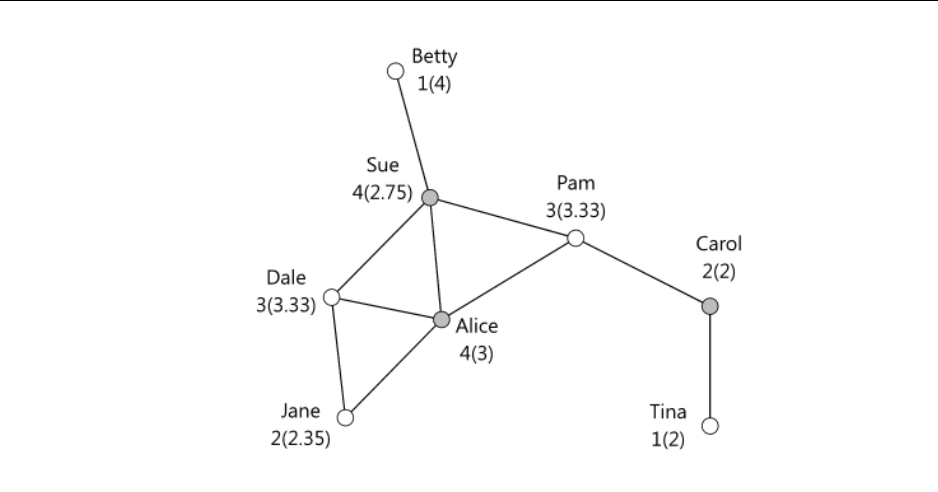
Figure 1: Friendships among eight girls in “Marketville” high school